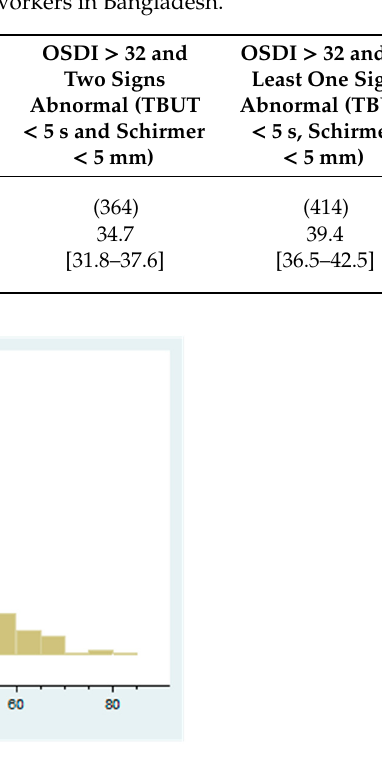
Figure 1. Histogram of Ocular Surface Disease Index (OSDI) values in factory workers.